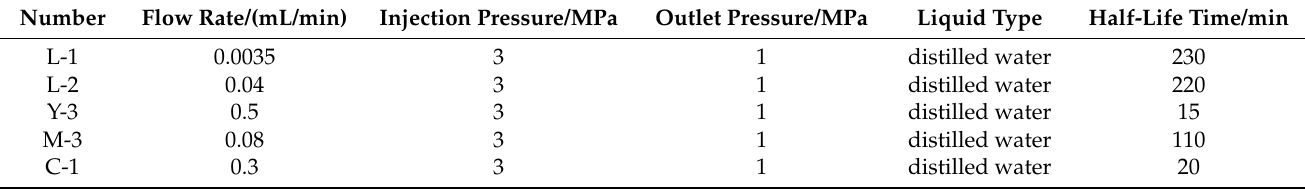
Table 4. The fracture connectivity characterized by the half-life